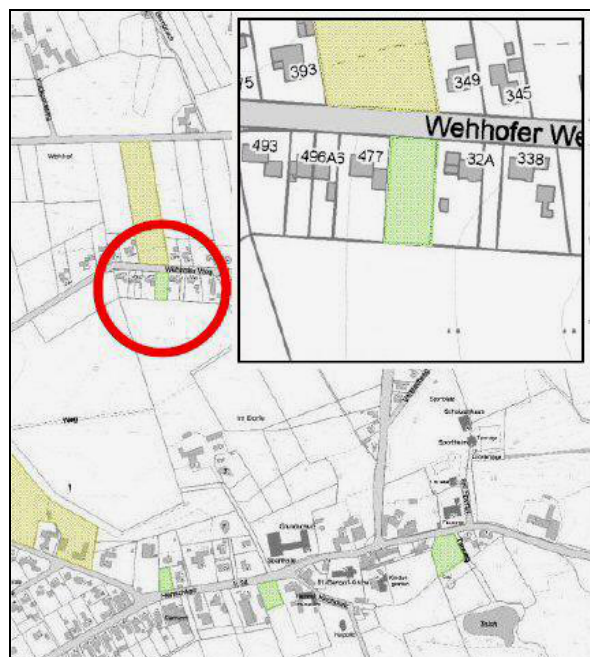
Figure 7: Inventory of potential construction sites (Kleinwächter